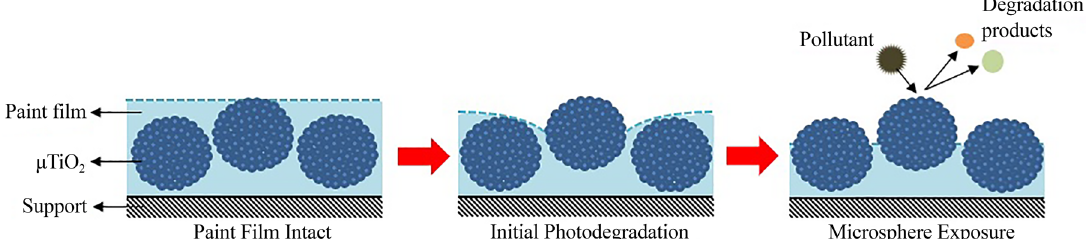
Figure 3. Scheme proposed for interactions in a paint film containing mesoporous TiO